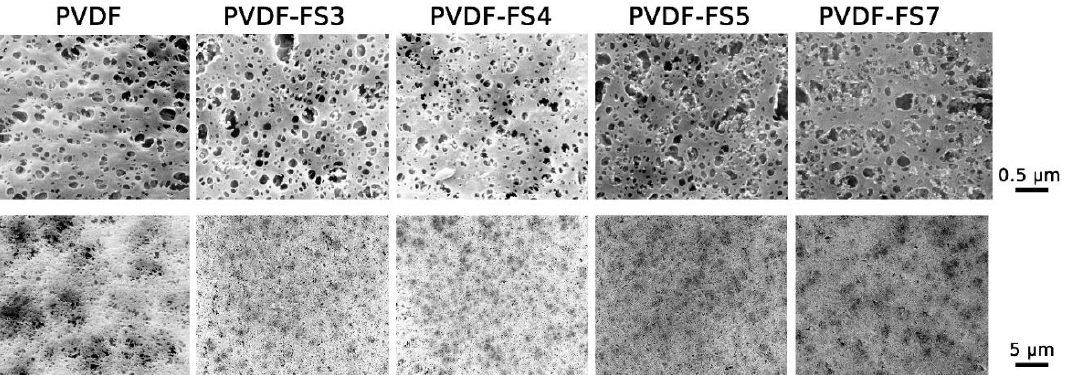
Figure 3. SEM images of the fabricated membranes. The results show that the FS particles agglomerated more as the amount of FS content added increased. The results also indicate that different contents of FS resulted in variable pore sizes, where the PVDF-FS4 and the PVDF-FS7 resembled the lowest and the largest pore sizes,